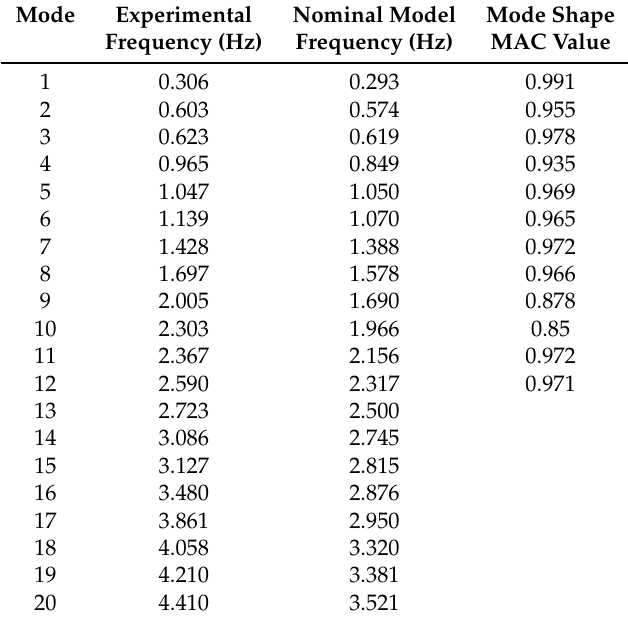
Table 1. First 20 experimentally identified modal frequencies of the the Metsovo bridge compared with the modal frequencies predicted by the nominal FE model of the bridge. MAC values between identified and model predicted mode shapes are also